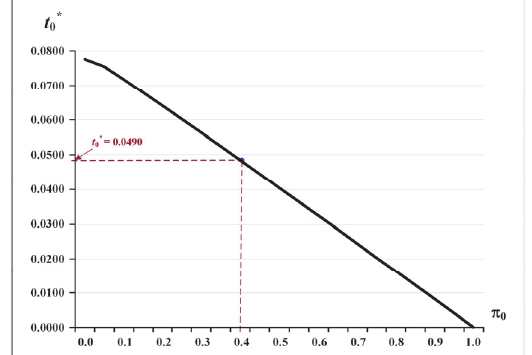
Fig. 8. The behavior of machine utilization (in percentage) vis-à-vis π